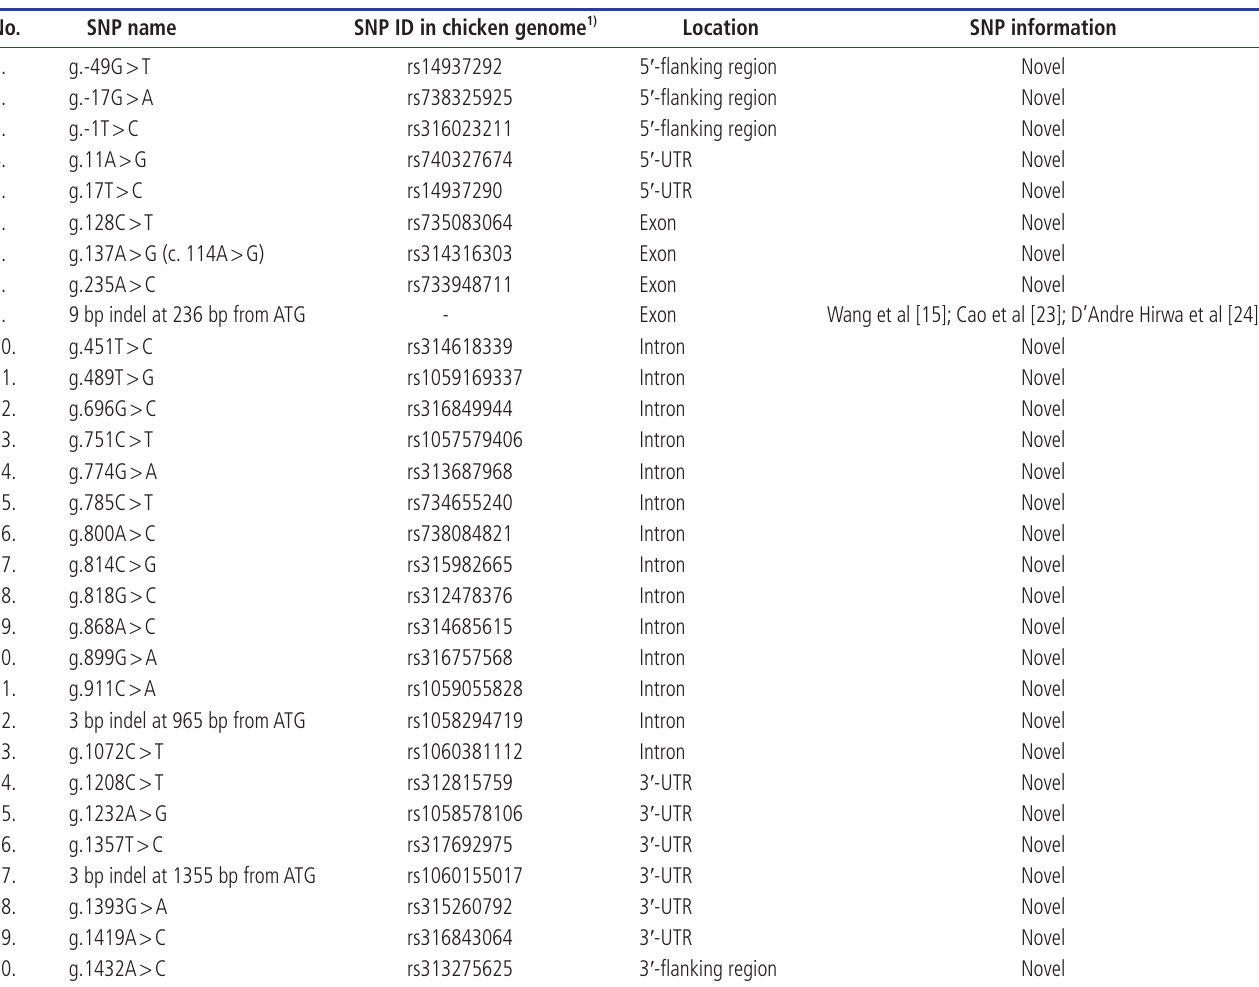
Table 1. Distribution of the THRSP gene polymorphism in Korean native chicken